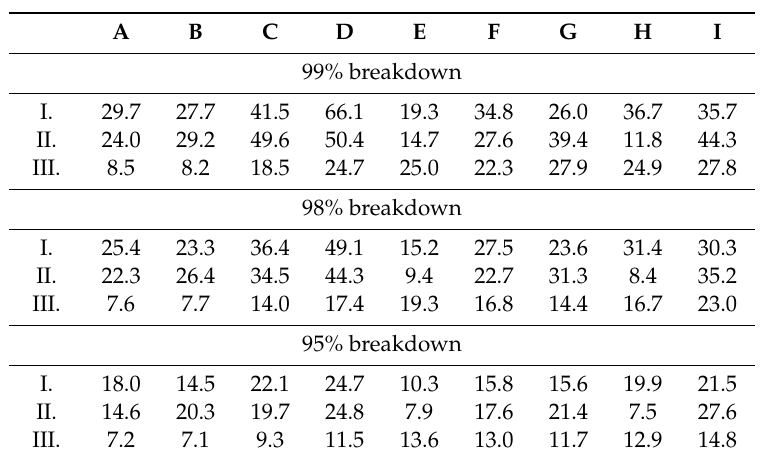
Table 4. Cost (USD as of February 2020) needed for 99%, 98% and 95% breakdown of 1 k kg of emulsion samples (A–I) according to methods I–III.